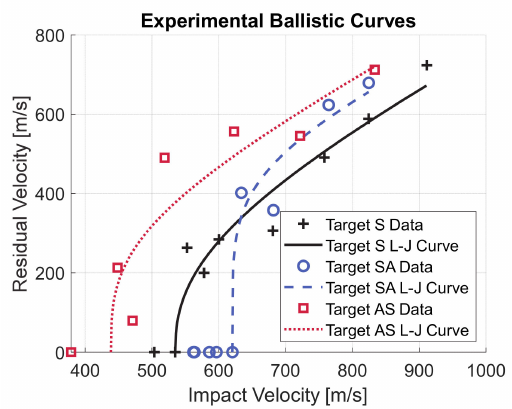
Figure 4. Experimental data and fitted ballistic curves.